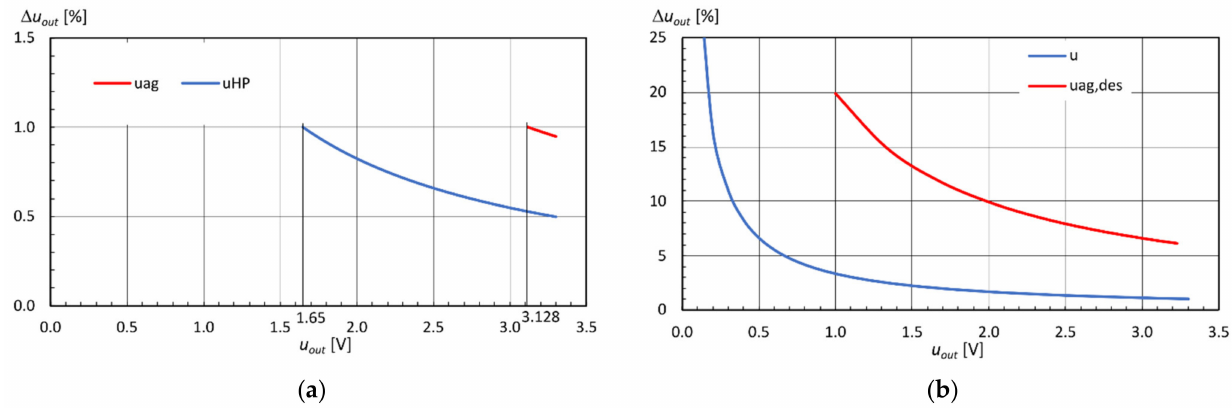
Figure 11. Percentage change of u out due to a 1% change in the reference voltage vs. the output voltage: ( a ) single-stage circuit; ( b ) two-stage